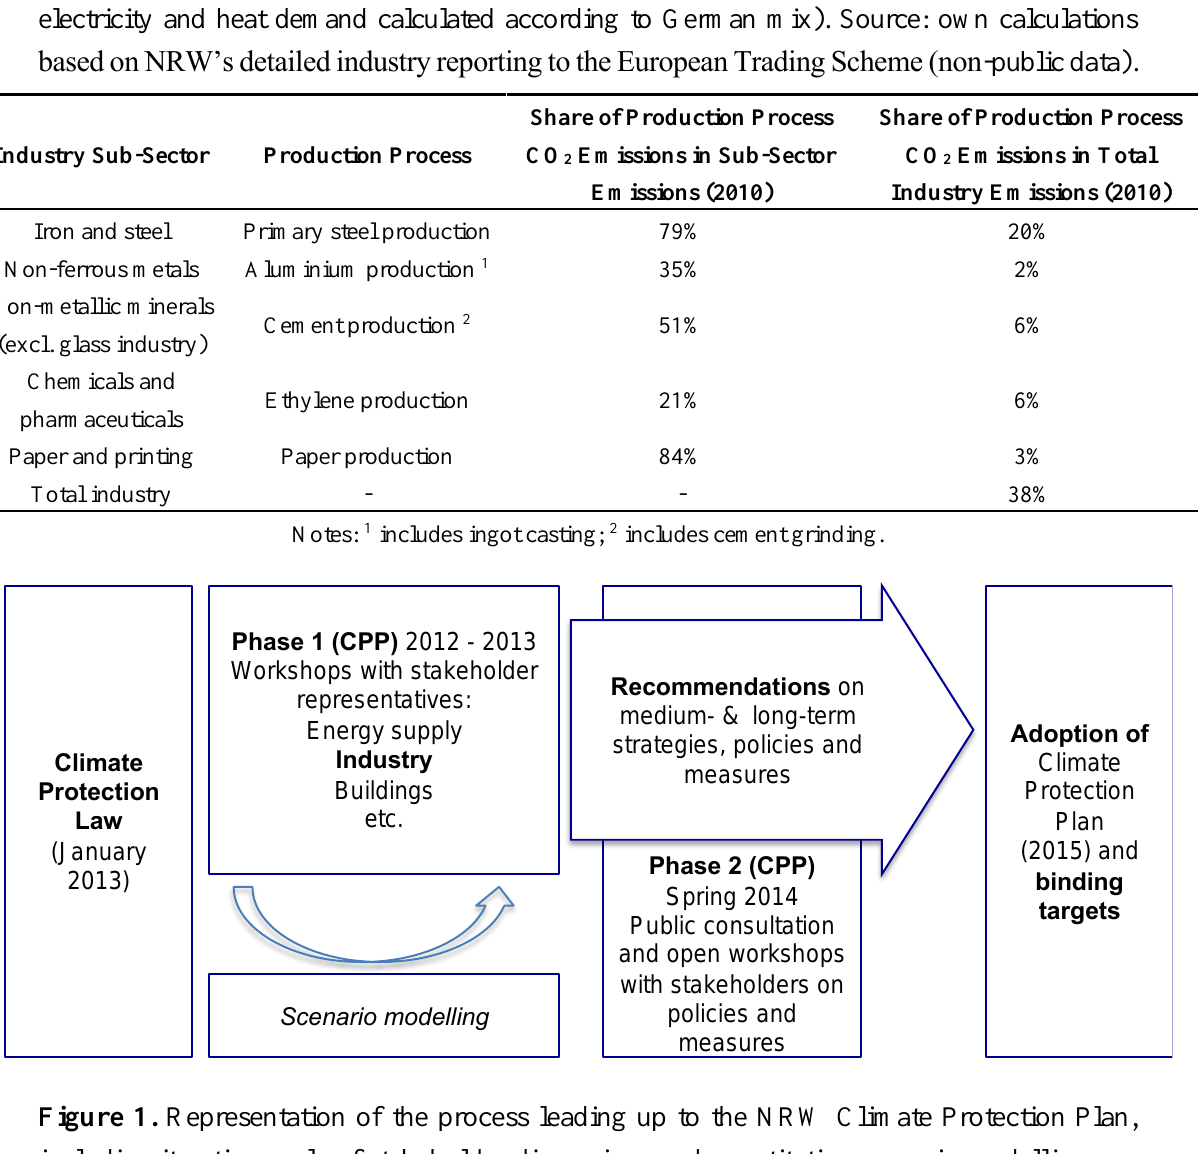
sub-sectors (Note: excludes industrial Combined Heat and Power (CHP); Emissions of